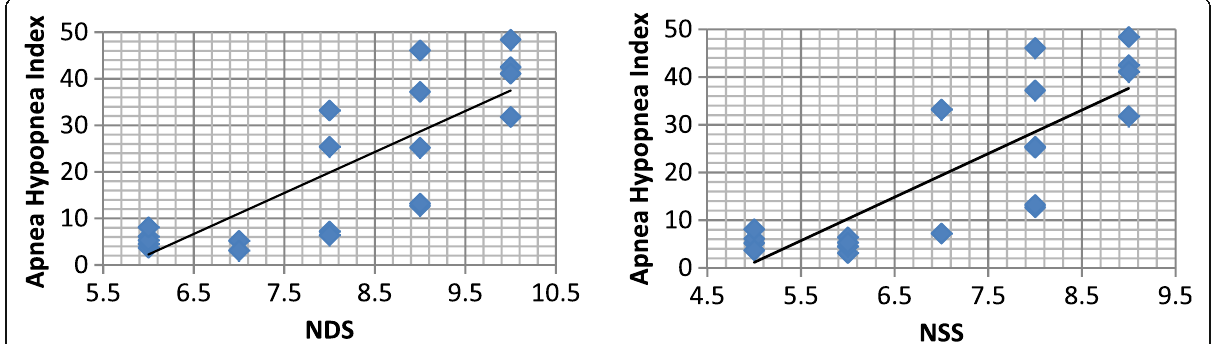
Fig. 2 Positive correlation between apnea hypopnea index and each of neuropathy disability score (left) and neuropathy symptom score (right) in diabetic peripheral neuropathy